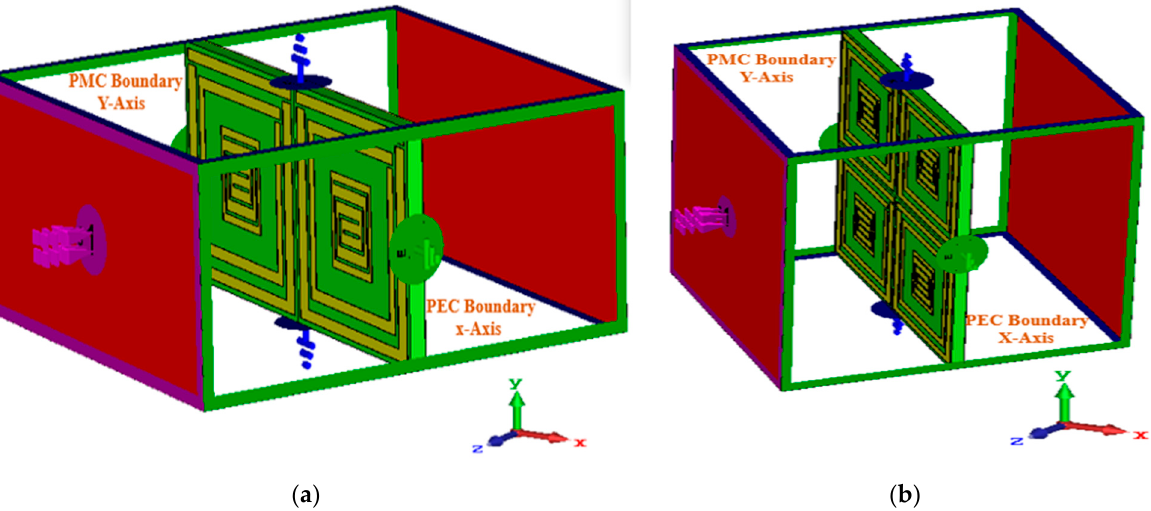
Figure 13. Array analysis. ( a ) 1 × 2 and ( b ) 2 × 2 with boundary conditions, PEC (perfect electric field) PMC (perfect magnetic field).